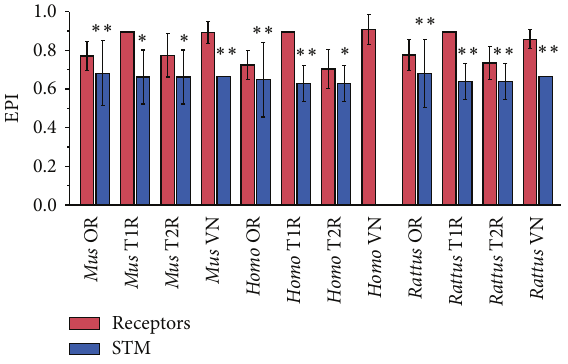
Figure 2: Mean EPI values of chemoreceptors families (red) and their respective signal transducing machineries (blue). Plasticity values are shown in the vertical axis and the different subgroups are listed on the horizontal axis. Whiskers represent the standard deviation. Statistically significant data are indicated by double ( 𝑃 < 0.001 ) and single ( 𝑃 < 0.05 )